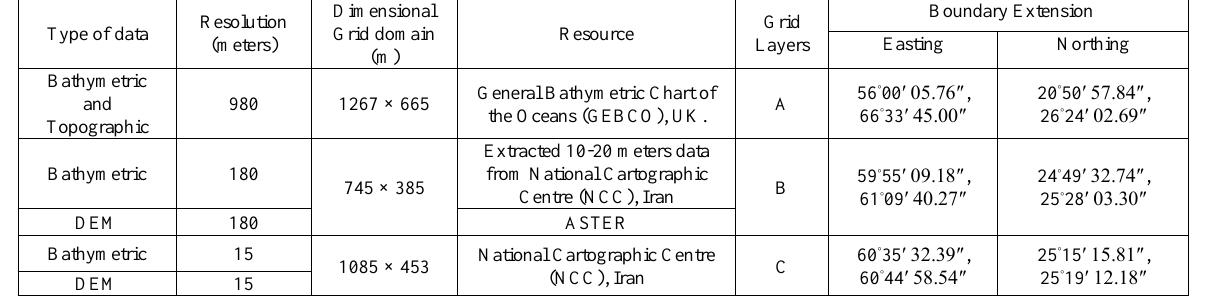
Table 2. Geo-spatial data used for Tsunami Simulation